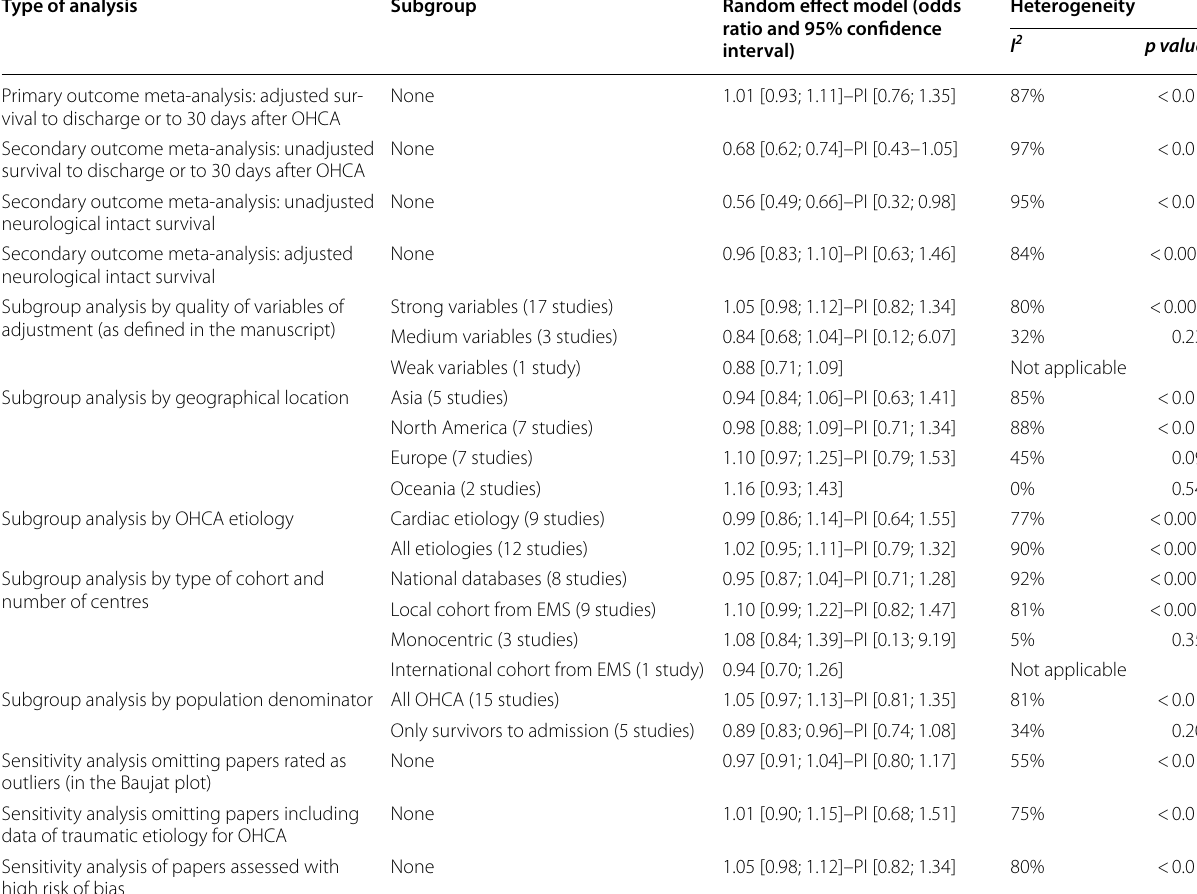
Table 3 Results of